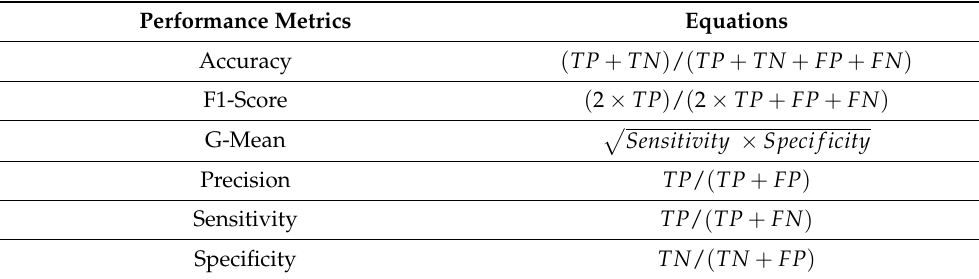
Table 2. Equations for performance